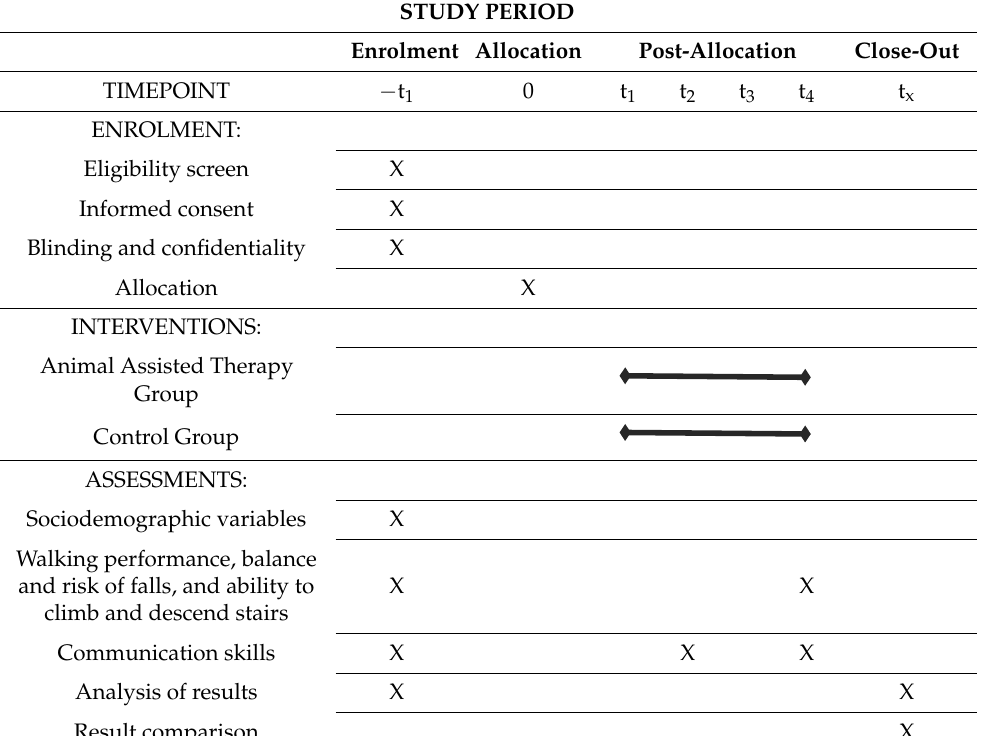
Table 1. Study schedule following SPIRIT guideline.